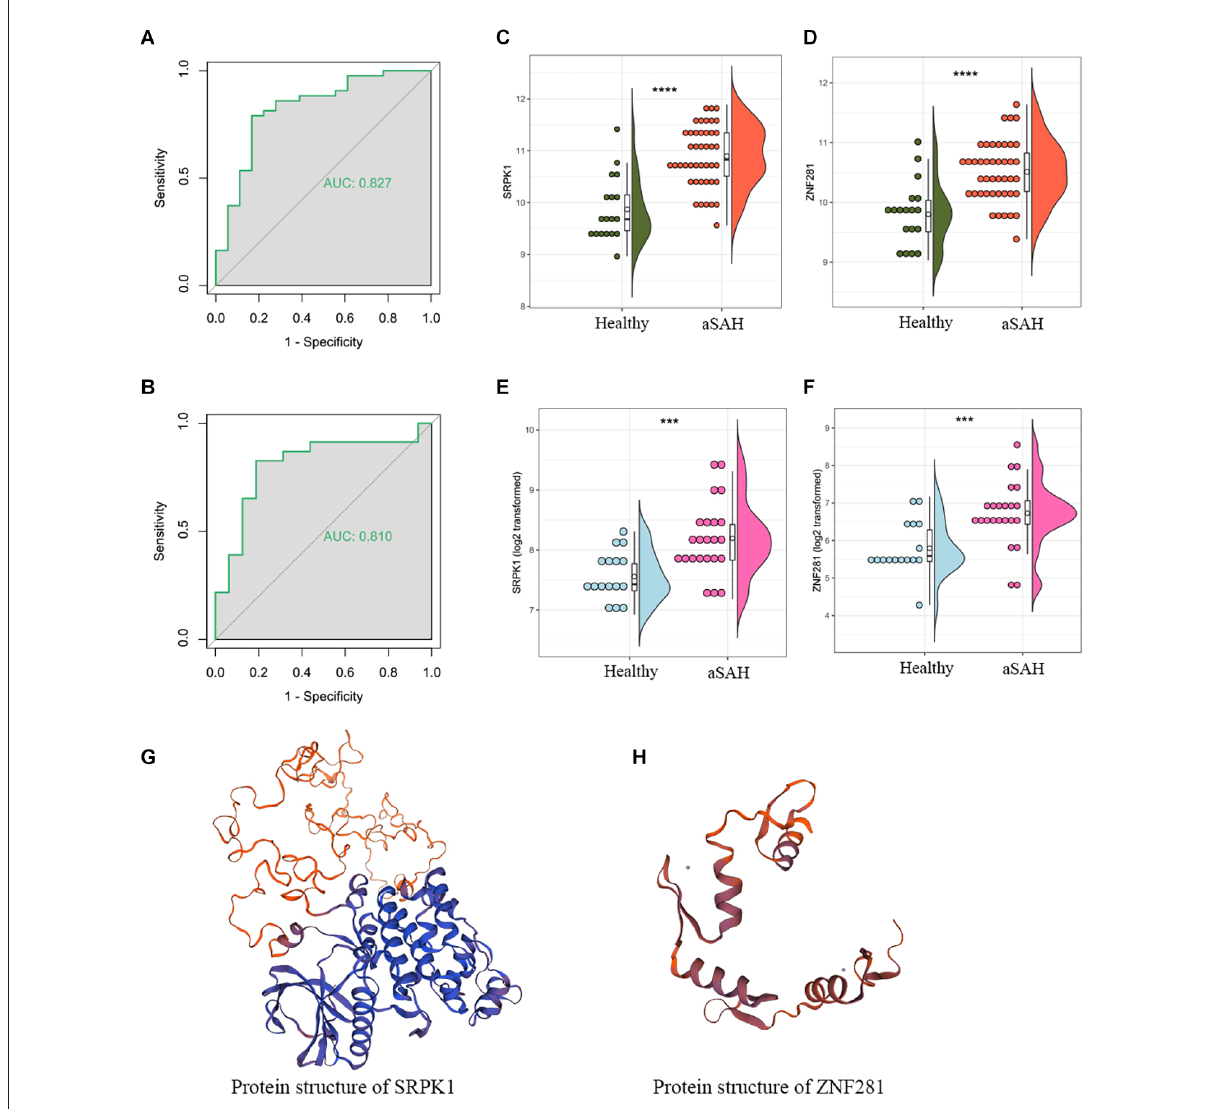
FIGURE7 The area under the curve (AUC) of ZNF281 was 0.877 and 0.810 in the (A) blood sample and (B) tissue sample dataset, respectively. (C,D) Expression profile of SRPK1 and ZNF281 in the blood sample dataset and (E,F) in the tissue sample dataset. (G,H) Protein structures of SRPK1 and ZNF281 (*** p < 0.001, **** p <